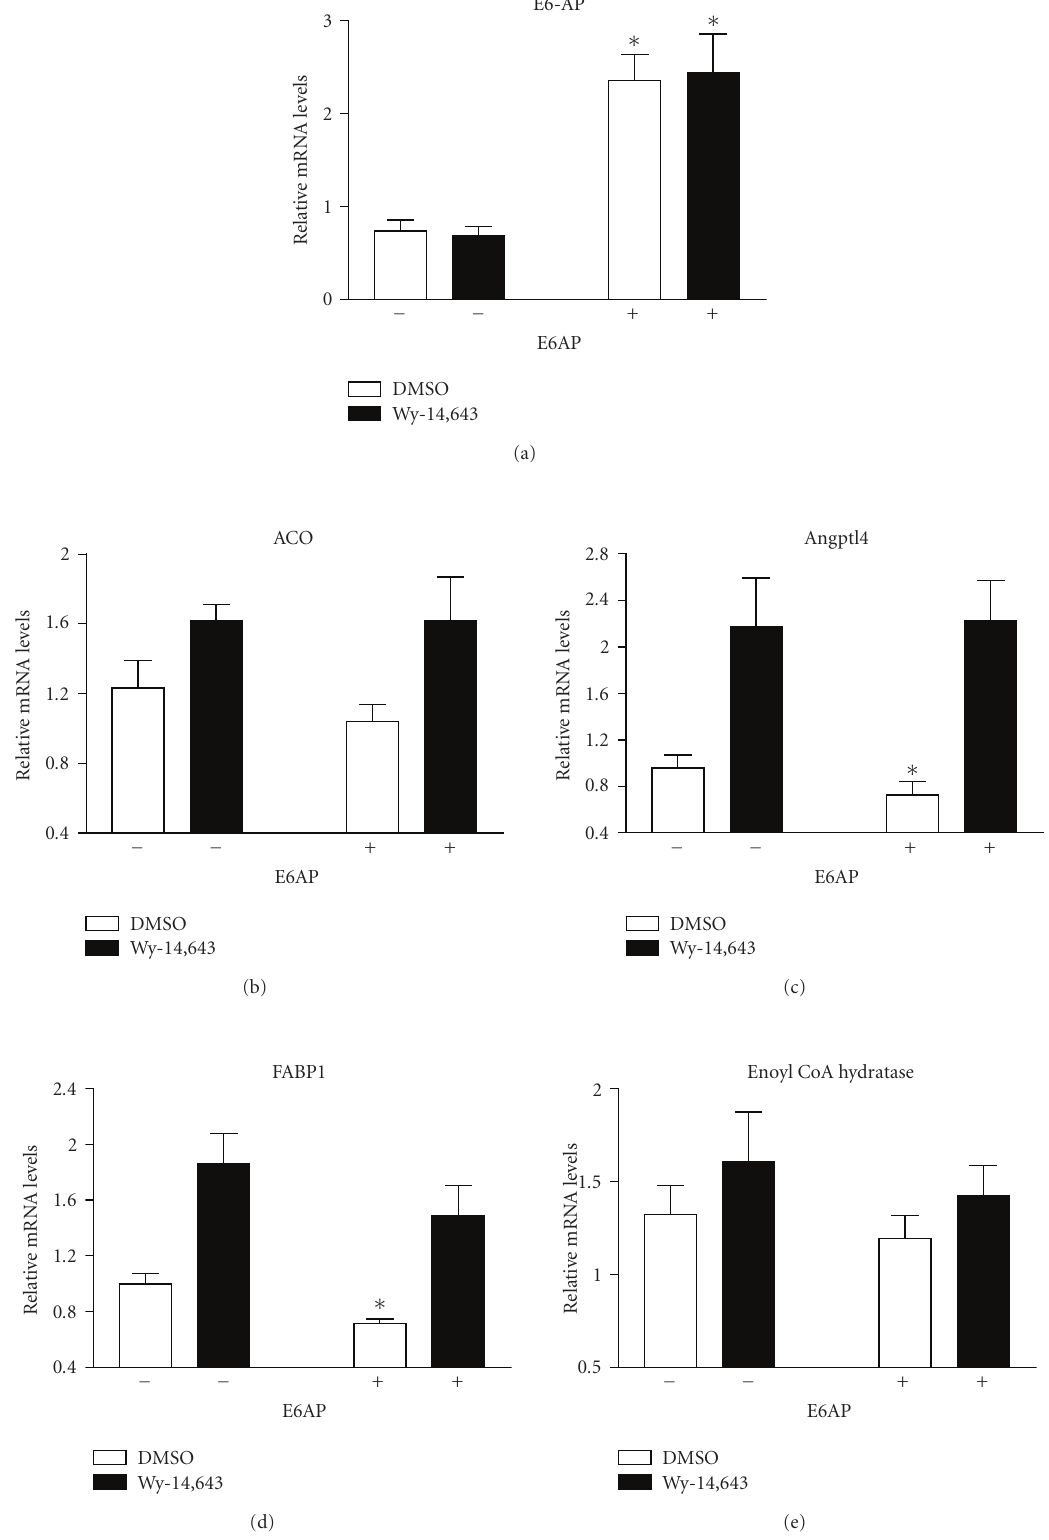
Figure 2: E6-AP expression results in decreased mRNA levels of PPAR α target genes. FaO cells were transfected with empty vector or plasmid expressing E6-AP, followed by treatment with 0.1% DMSO or 50 μ M Wy-14,643 for 6 hours. Total RNA was isolated from the cells and real- time PCR was performed on reverse transcribed RNA. Asterisks indicate a significant di ff erence when compared to the corresponding control group. ( ∗ P < . 05 with statistical analysis using ANOVA). The graphs represent mean values obtained from 2 independent